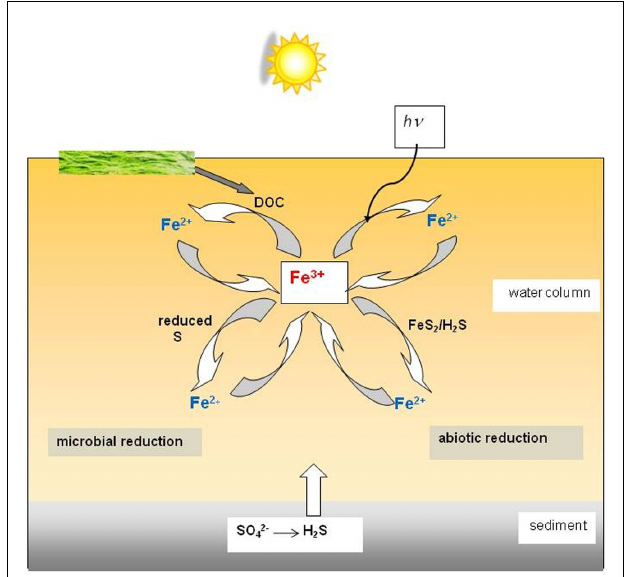
FIGURE 6 | Schematic of the different microbial and abiotic routes of ferric iron reduction in an acidic (pH < 3) stream, river, or pit lake. Abiotic iron oxidation proceeds slowly in these environments, and is primarily mediated by prokaryotic